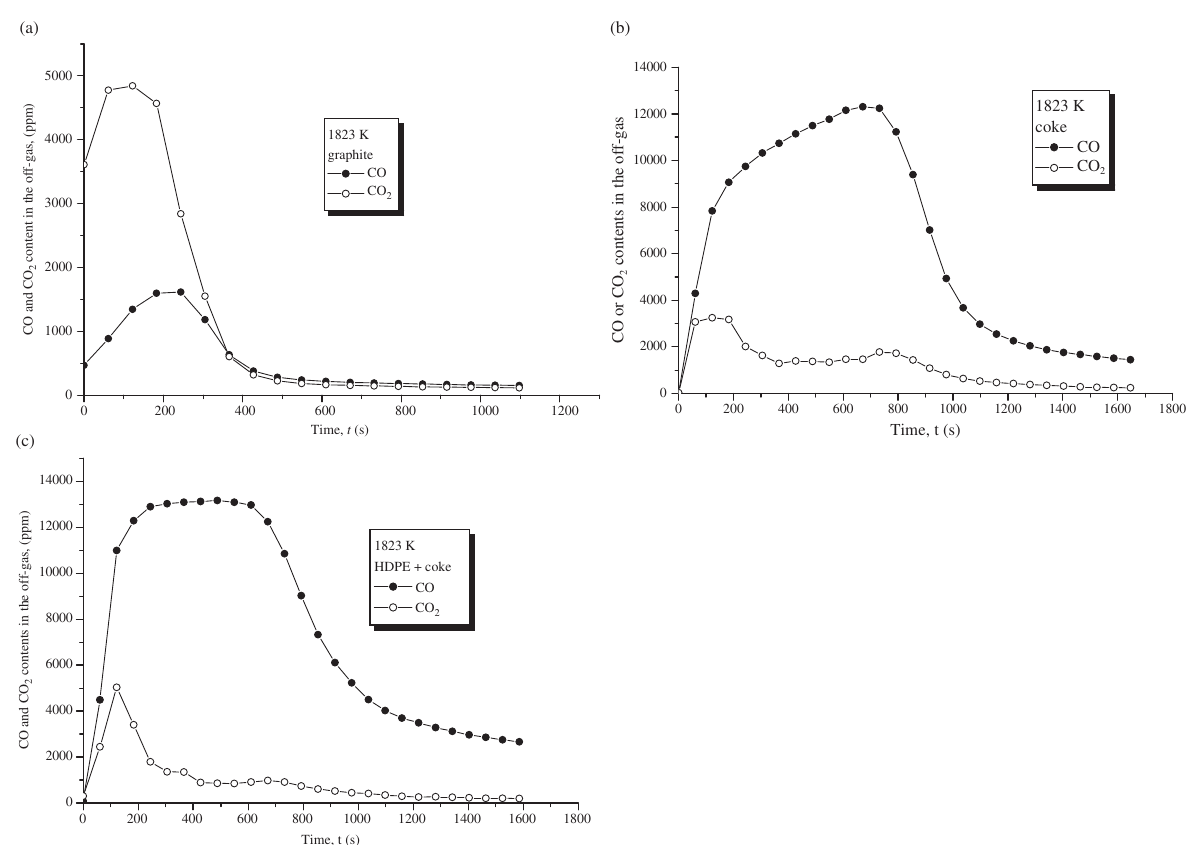
Figure 2: (a) Change of CO and CO 2 contents in the off-gas with time for graphite. (b) Change of CO and CO 2 contents in the off-gas with time for coke. (c) Change of CO and CO 2 contents in the off-gas with time for the mixture of HDPE and